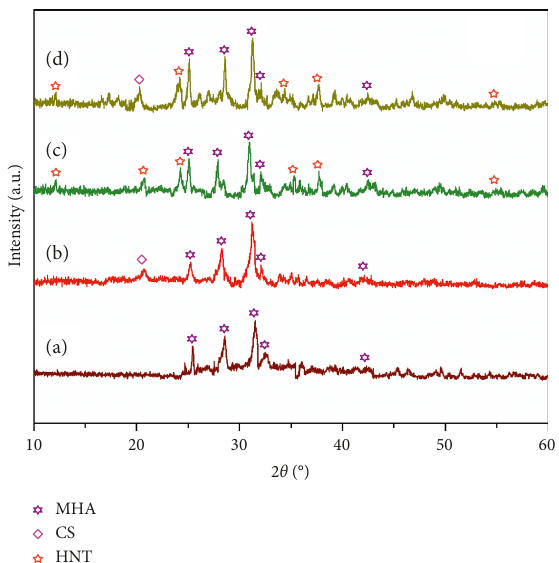
Figure 3: XRD patterns of (a) MHA coated on Ti6Al4V alloy, (b) CS-MHA coated on Ti6Al4V alloy, (c) HTN-MHA coated on Ti6Al4V alloy, and (d) HTN-CS-MHA composite coated on Ti6Al4V